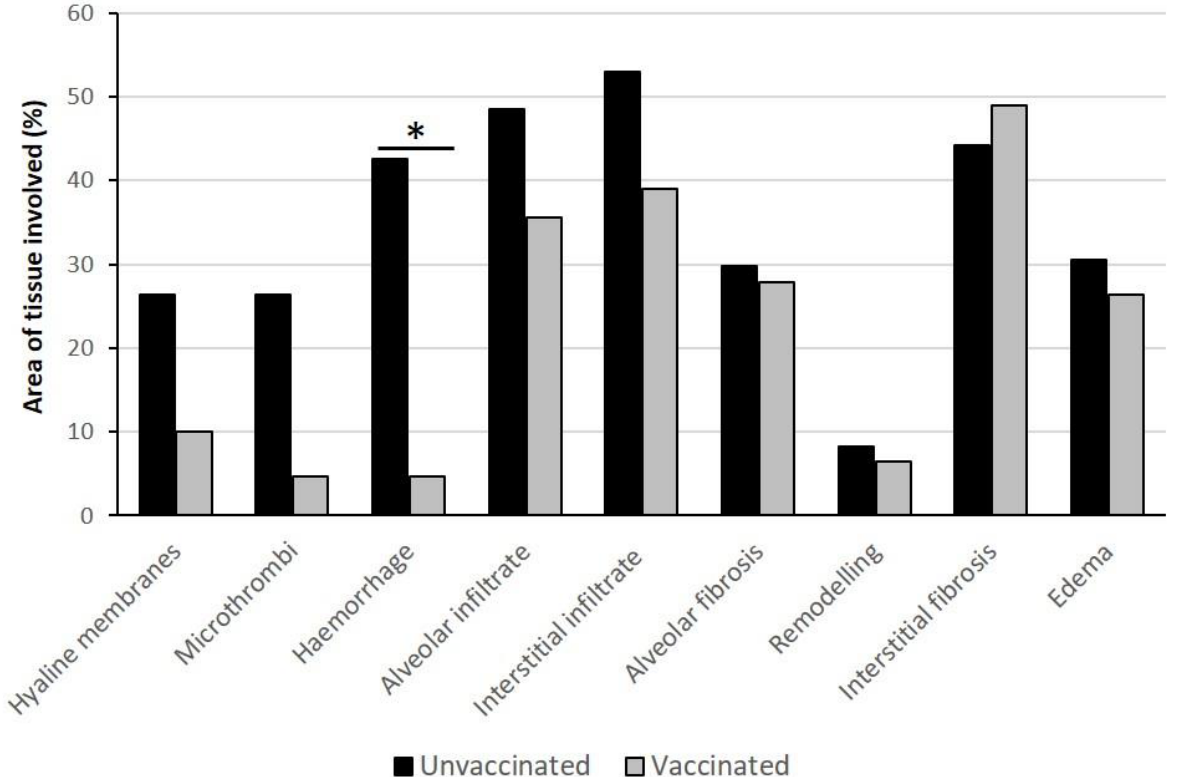
Figure 2. Histology score of lung damage in unvaccinated and vaccinated COVID-19 patients. Histological features of lung damage were scored according to the percentage of the tissue area involved. Some pathological changes show higher values in unvaccinated vs. vaccinated patients.